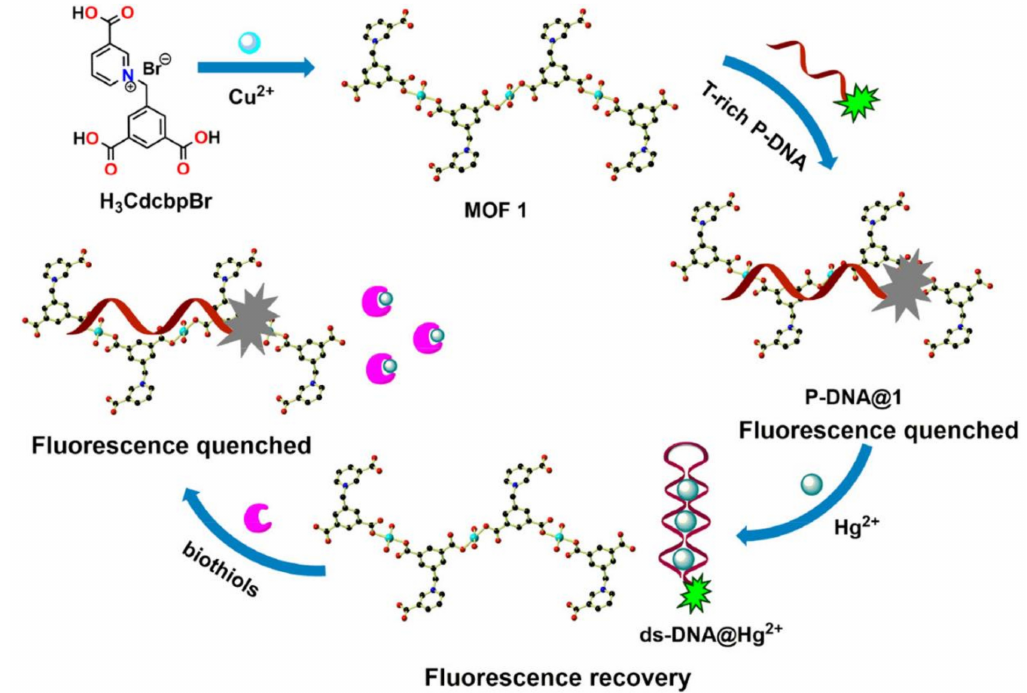
Figure 6. The proposed Hg 2+ and biothiols detection mechanism based on the P-DNA@1 hybrid (Reproduced with the permission from Ref